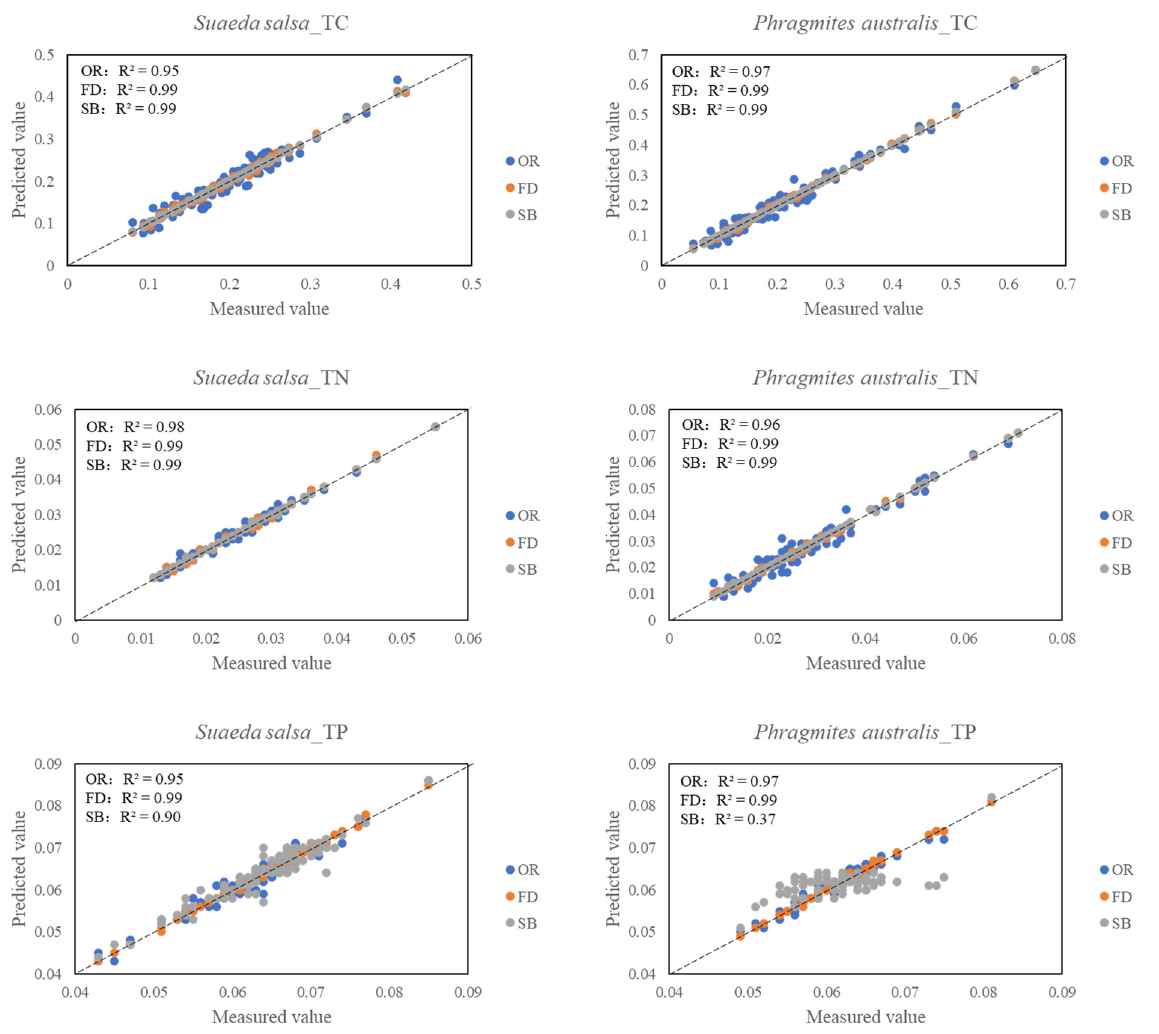
Figure 7. PLSR modelling results for P. australis and S. salsa. OR: original reflectance; FD: first derivative reflectance; SB: sensitive band.